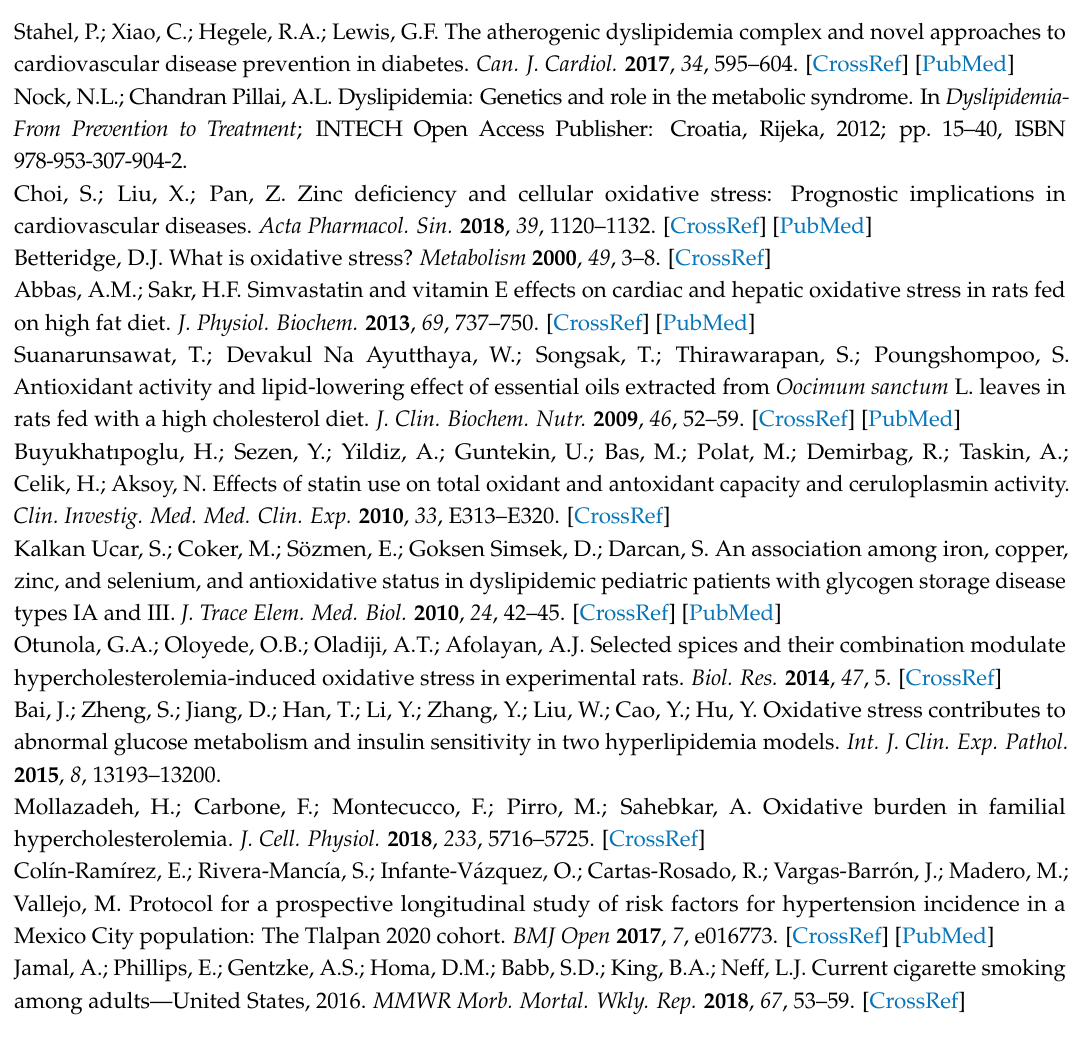
s1. Table S1. Analysis of the activity of antioxidant enzymes and FRAP according to factors associated with dyslipidemia or antioxidant enzyme activity. Table S2. Association between antioxidant enzyme activities and FRAP. Table S3. Results from the linear regression models considering the main effects of the components of lipid profiles and their association with the activity of superoxide dismutase-1, catalase, and FRAP. Excel sheet: Multiplicity